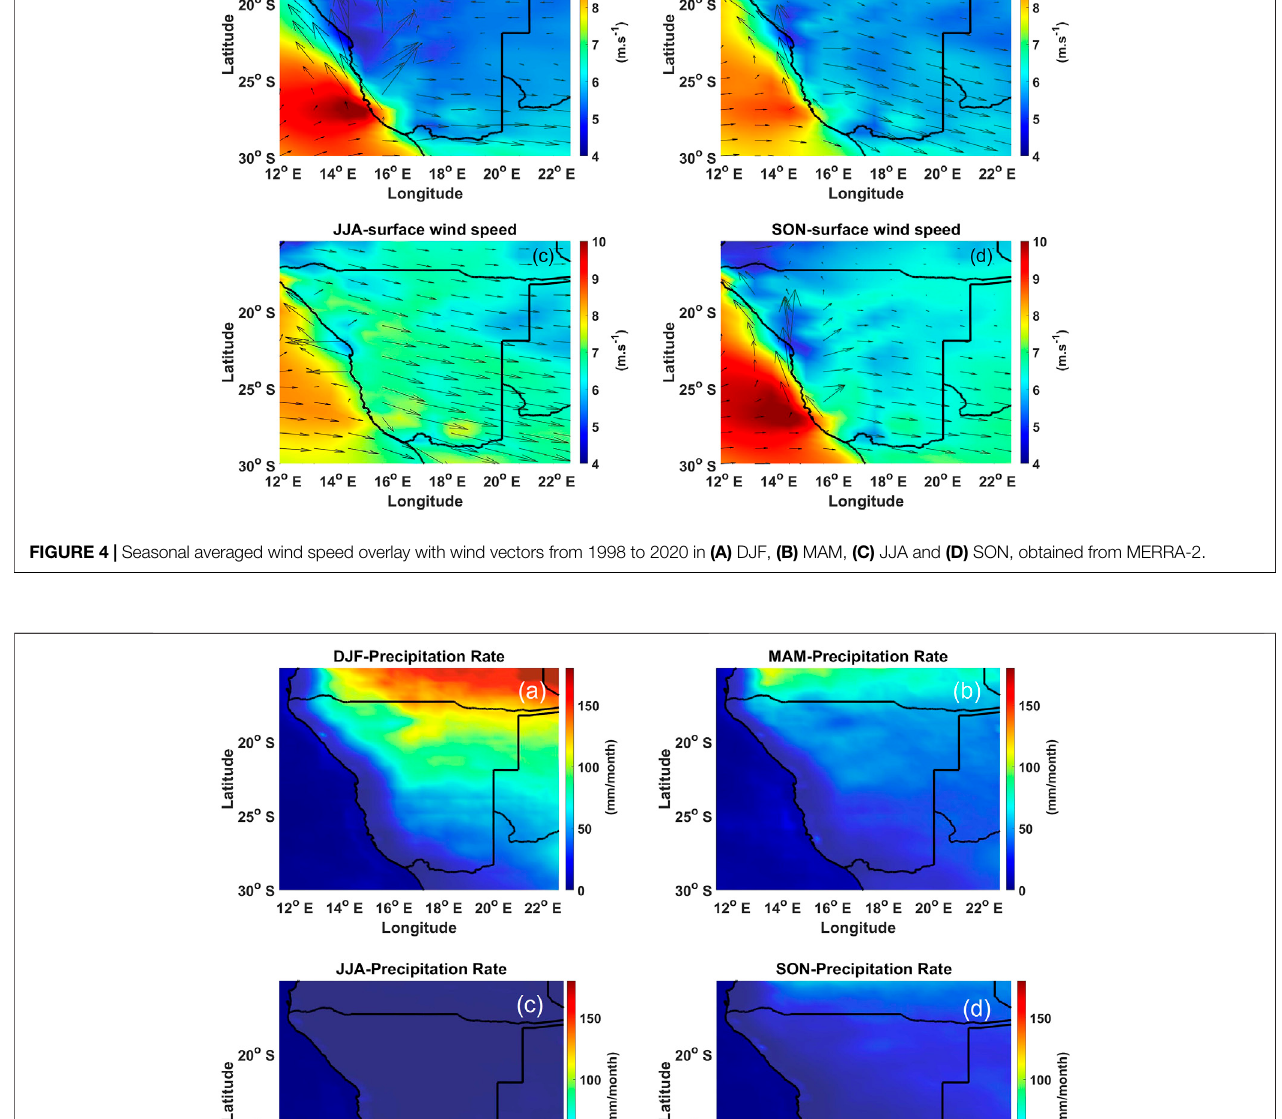
Frontiers in Environmental Science |